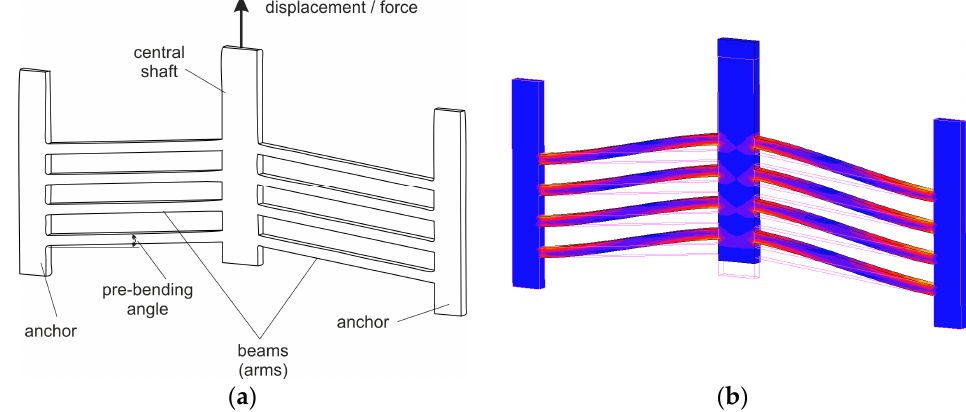
Figure 1. Chevron type microactuator: ( a ) typical geometry of the microactuator; ( b ) deformation and map of equivalent stress in the microactuator.